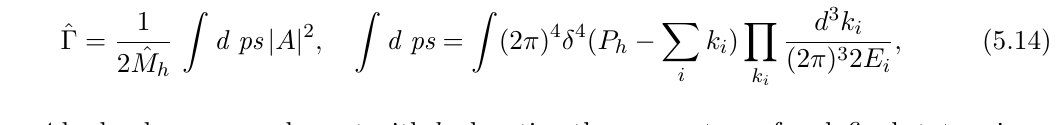
operator insertions perturbing the SM prediction through two charged current